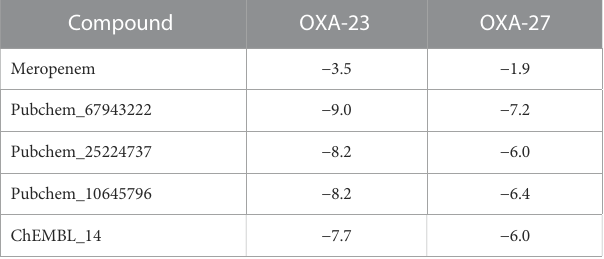
TABLE 3 Covalent docking values of meropenem and its analogs against OXA- 23 and OXA-27.